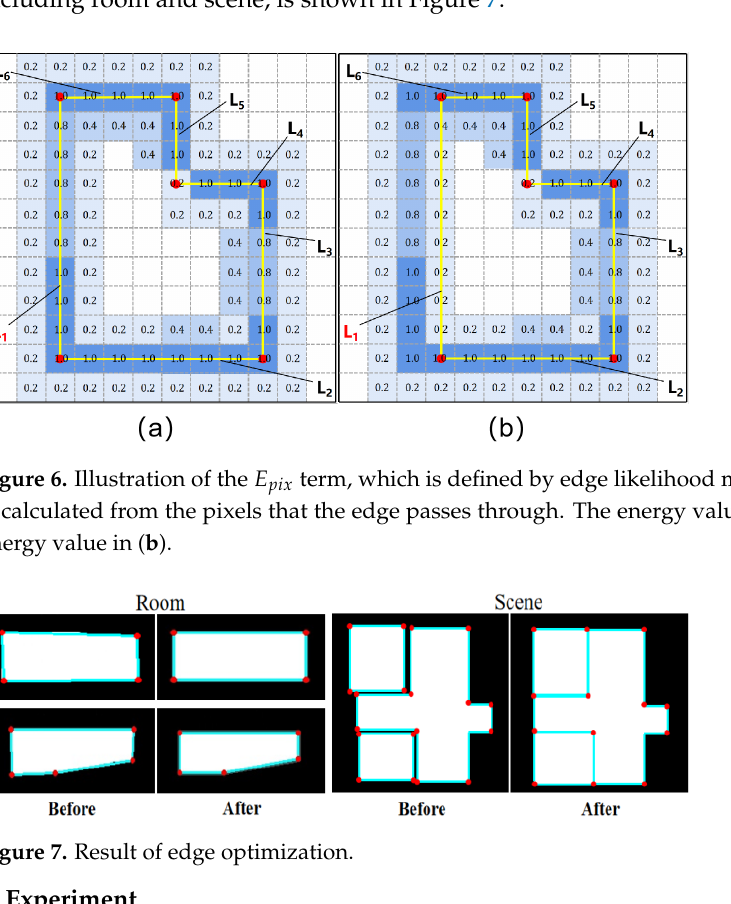
, , and terms. is the angle deviation formula, is the coincidence formula. ( a ) and ( b ) indicate defects in in- 𝐸𝐸 𝑚𝑚𝑤𝑤 𝐸𝐸 𝑙𝑙𝑤𝑤 𝐸𝐸 𝑐𝑐 𝐸𝐸 𝑚𝑚𝑤𝑤 𝐸𝐸 𝑐𝑐